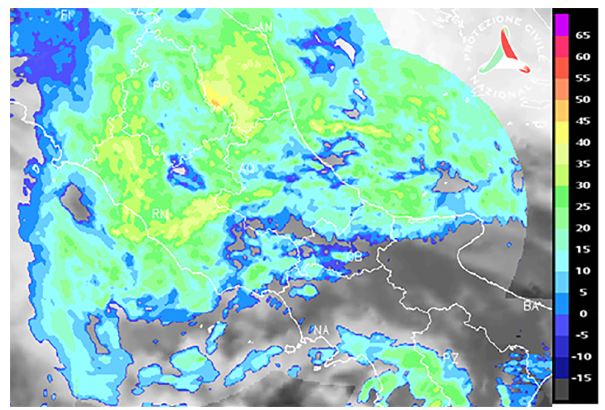
Figure 5. WRF ndown domain configuration: the two domains have resolution of 12 and 3km, respectively. The high-resolution D02 over Italy includes Mt Midia (MM), ISAC-CNR (P55C) and San Pietro Capofiume (SPC) radars (red dots in the